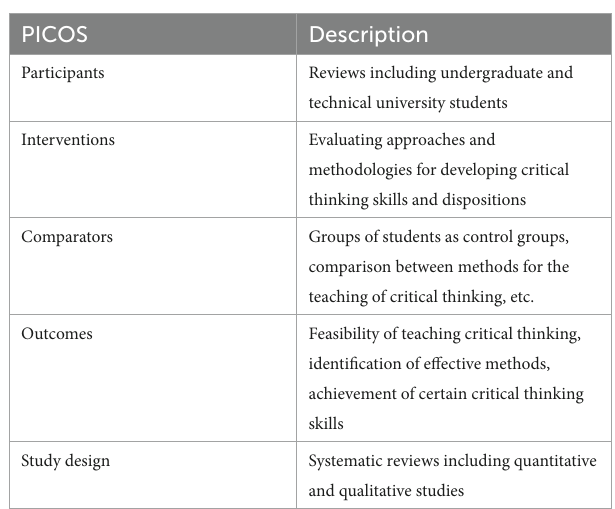
TABLE 1 Eligibility criteria using PICOS (participants, interventions, comparators, outcomes, and study